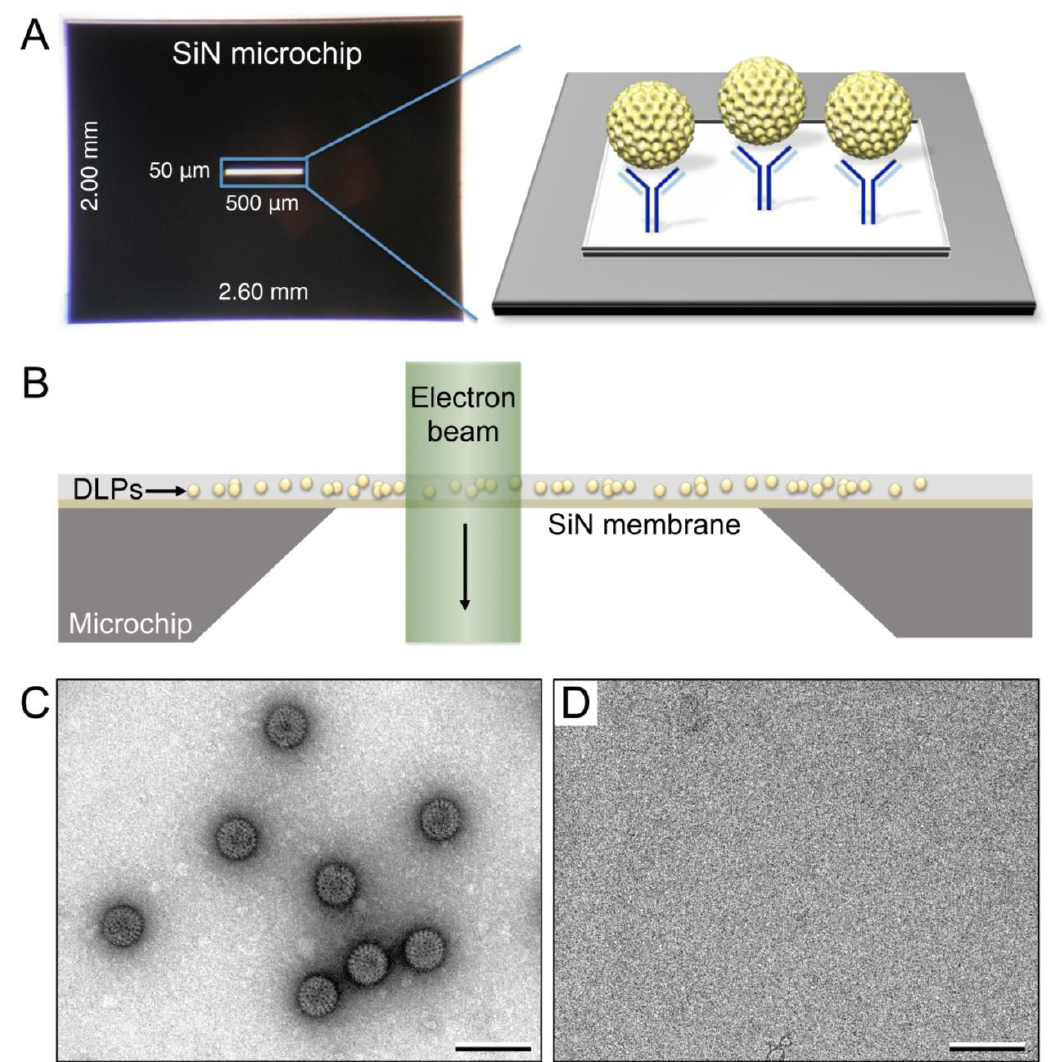
Figure 1. ( A ) Silicon nitride (SiN) microchips containing 50-nm thick imaging window were functionalized and decorated with Protein A and IgG antibodies (blue) used to recruit viral complexes (yellow). ( B ) Cross-sectional view of a SiN microchip decorated with double-layered particles (DLPs) and oriented with respect to the electron beam. ( C ) Representative electron microscopy (EM) images indicated that rotavirus DLPs bind specifically to functionalized microchips decorated with antibodies and little to no